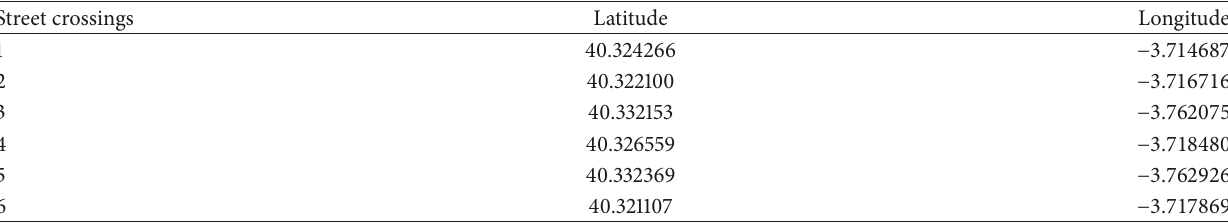
Table 4: Street crossing locations.